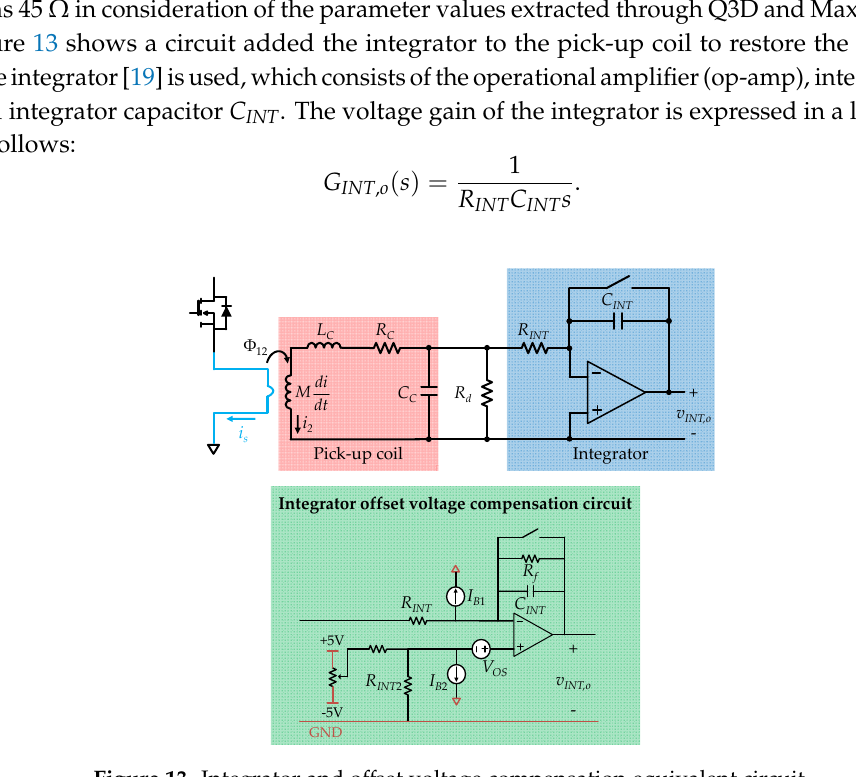
Figure 13. Integrator and offset voltage compensation equivalent circuit.